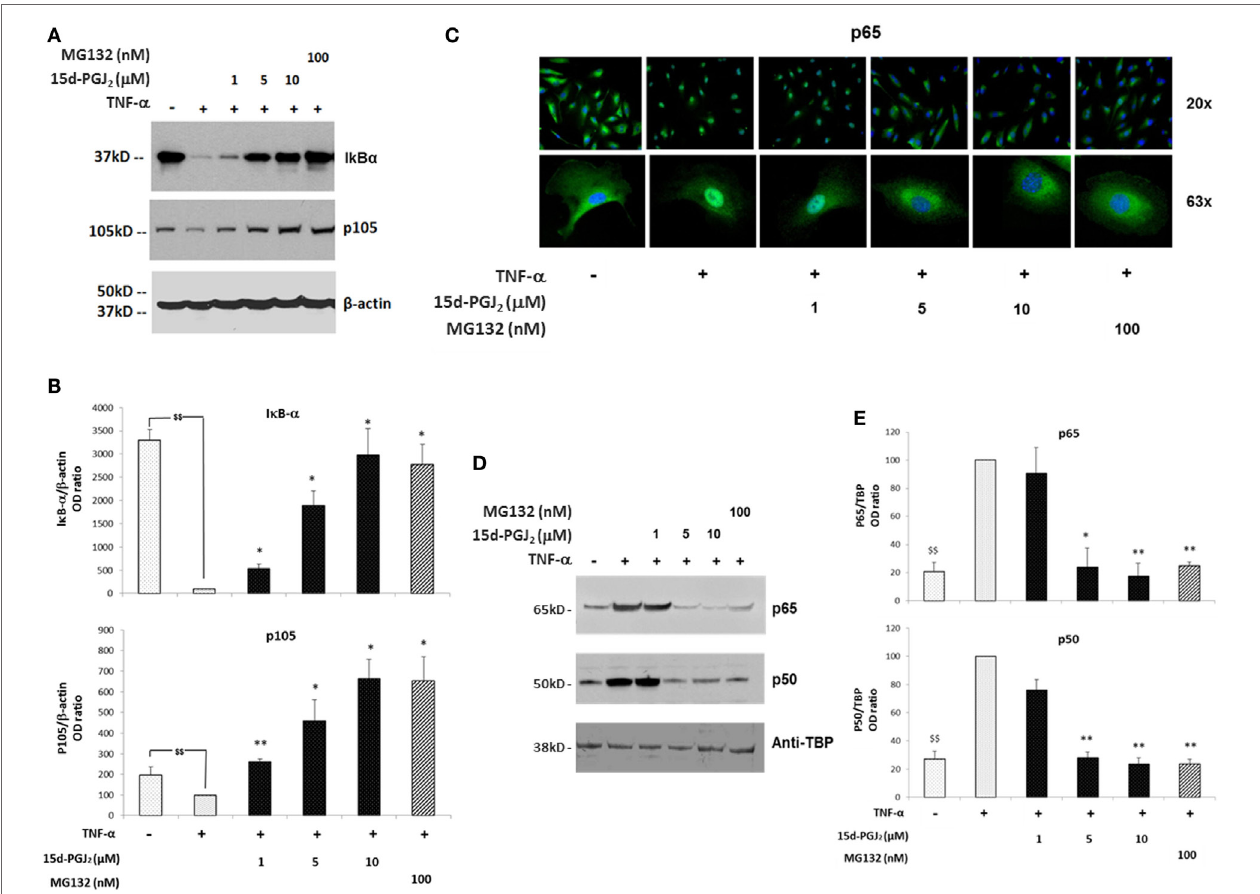
FigUre 3 | effects of 15d-PgJ 2 on cell signal-induced degradation of i κ B- α and p105 and on nF- κ B nuclear translocation . (a) EC were treated with 15d-PGJ 2 (1–10 μ M) or MG132 (100 nM) for 18 h, followed by 30min stimulation with TNF- α (0.2 ng/ml). Proteasomal IkB- α degradation and p105 processing were estimated by Western blotting of the indicated protein, and β -actin was used as loading control. The effect of the proteasome inhibitor MG132 is also shown.